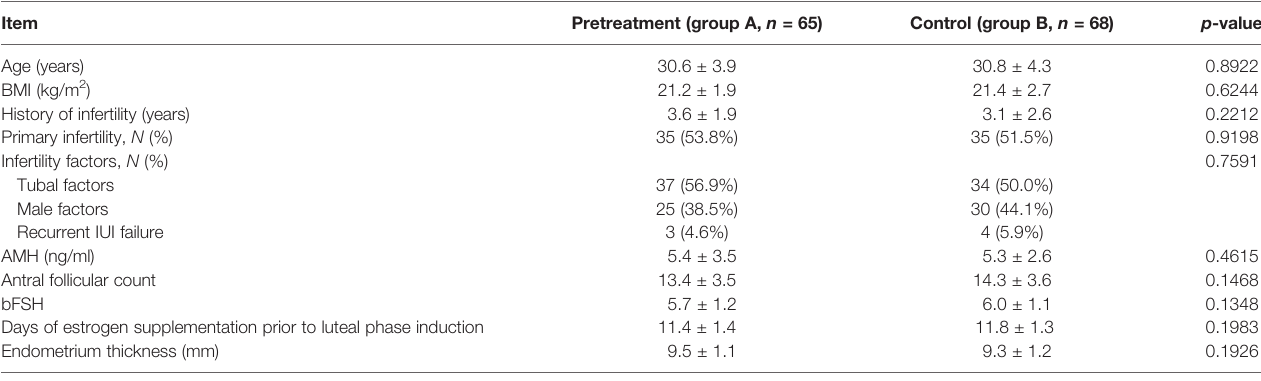
TABLE 1 | Baseline characteristics (intention-to-treat